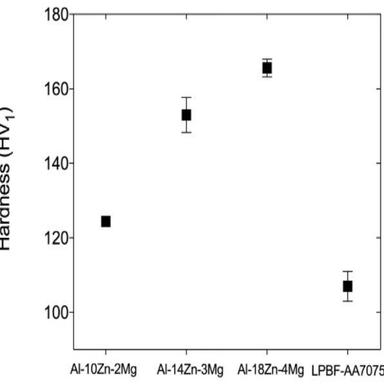
Hardness of LPBF prepared Al-10Zn-2Mg, Al-14Zn-3Mg and Al-18Zn-4Mg in comparison with LPBF-AA7075.